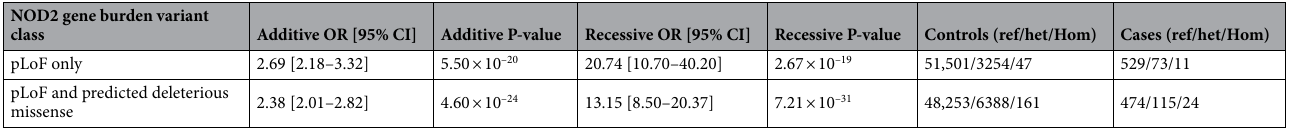
Table 4. Comparison of additive and recessive models for heterozygous, homozygous, and phased compound heterozygous pLoF and predicted deleterious missense variants for NOD2 variants (MAF < 5%) for Crohn’s Disease Risk in